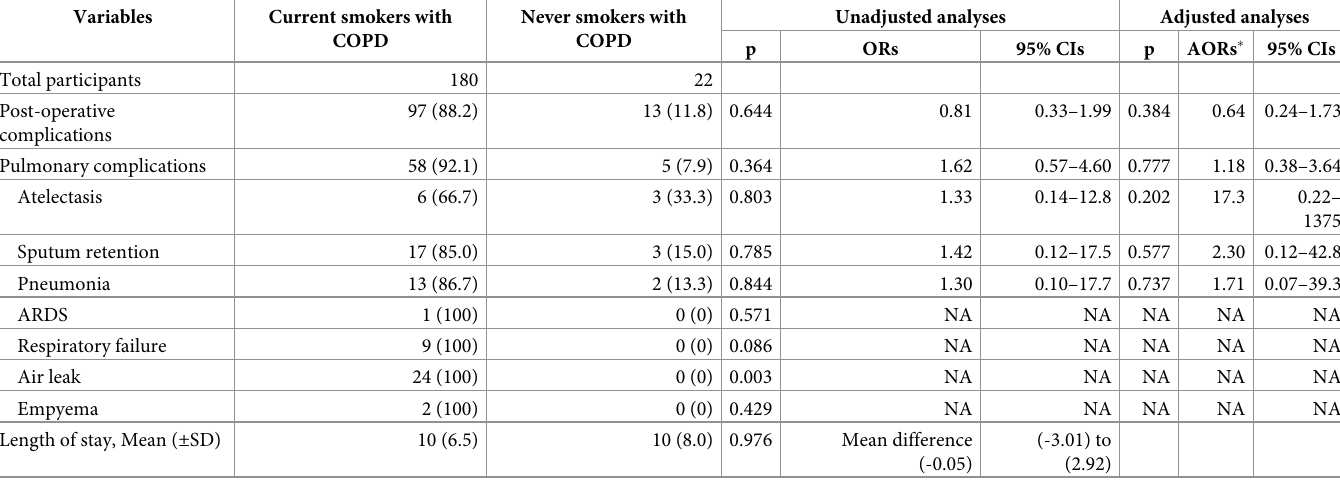
Table 4. Complication rates grouped by smoking status (current and never-smokers) amongst COPD patients.